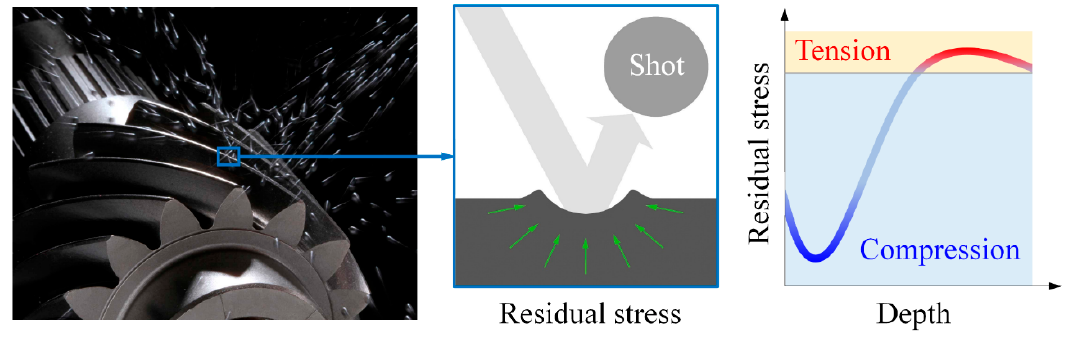
Figure 1. Shot peening in gear manufacturing and typical residual stress (RS) distribution.